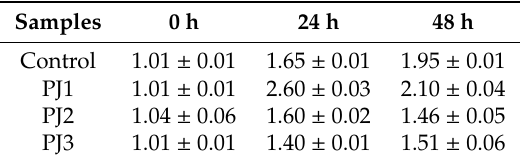
Table 2. Kefir weight in all fermented samples, expressed in